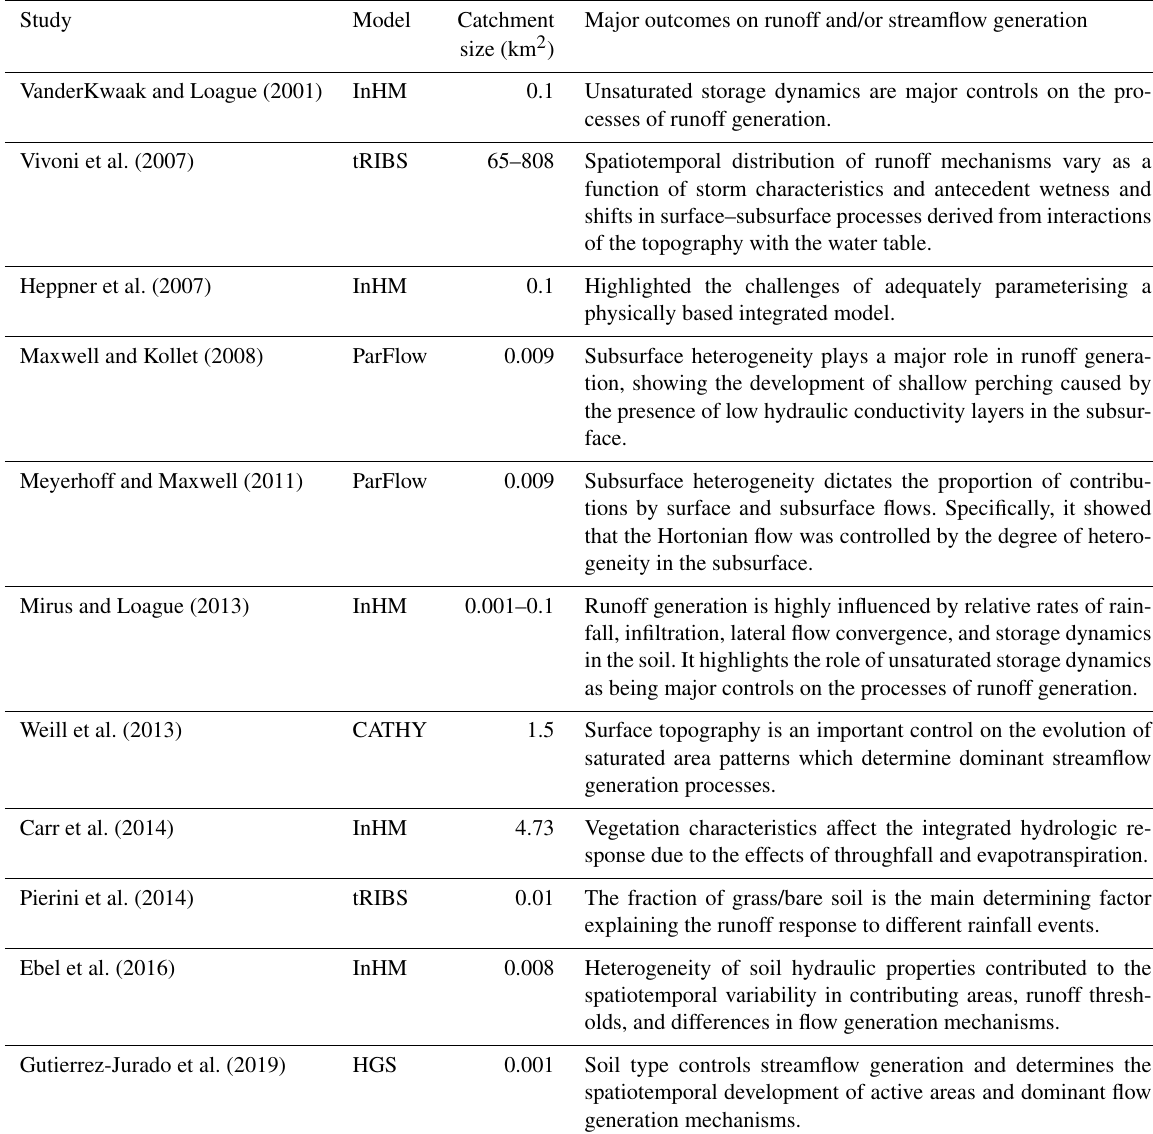
Table 1. Chronology of modelling studies advancing the understanding of runoff and/or streamflow processes in non-perennial systems. Study Model Catchment Major outcomes on runoff and/or streamflow generation size (km 2 ) VanderKwaak and Loague (2001) InHM 0.1 Unsaturated storage dynamics are major controls on the pro- cesses of runoff generation. tRIBS 65–808 Spatiotemporal distribution of runoff mechanisms vary as a function of storm characteristics and antecedent wetness and shifts in surface–subsurface processes derived from interactions of the topography with the water